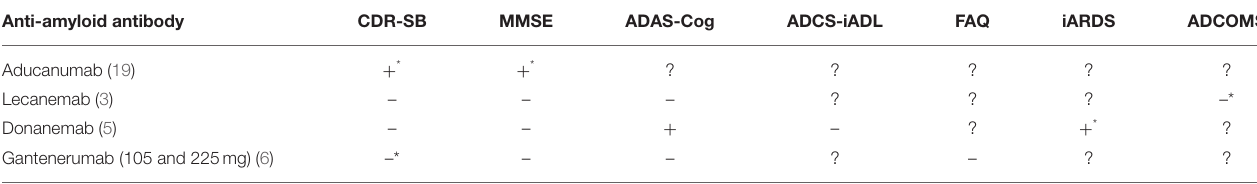
TABLE 2 | Mean changes in cognitive function assessment scores from baseline compared to placebo.